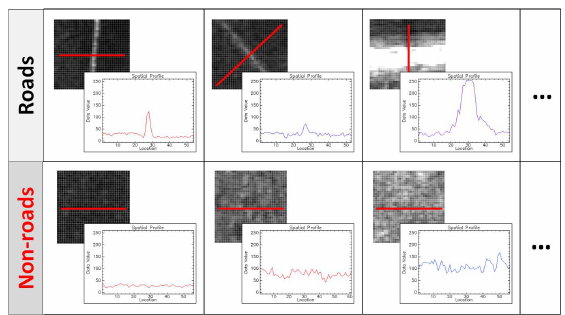
Figure 2: Examples of patterns of roads and non-roads to train the SOM network.